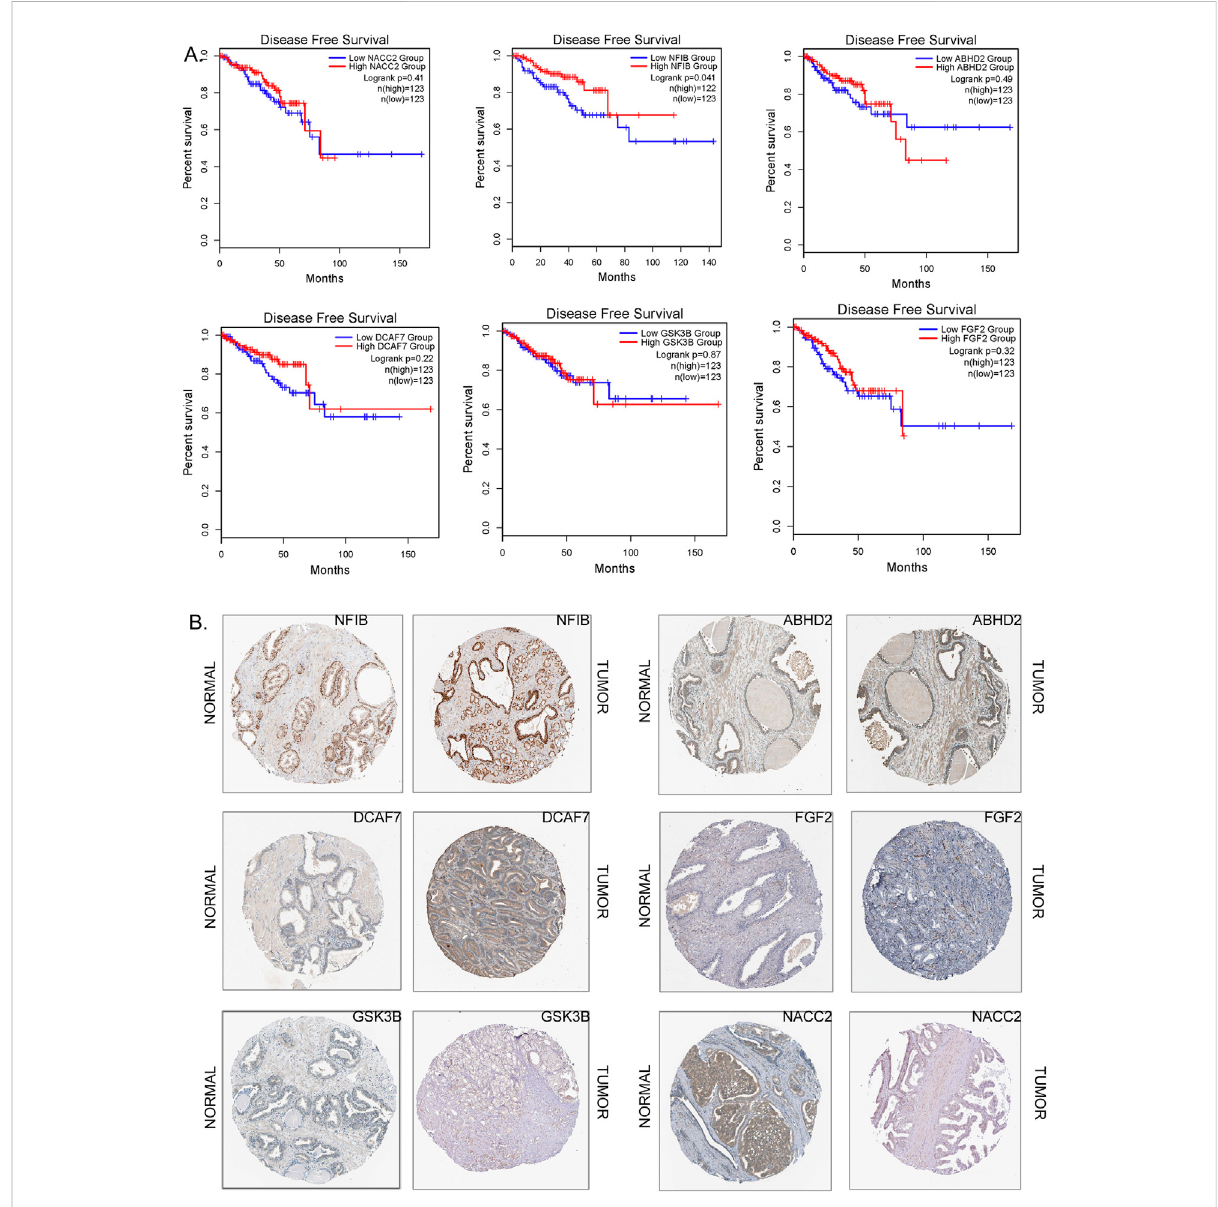
FIGURE 6 (A) TheKaplan-Meiersurvivalcurvesasprognosticvalues(diseasesurvivalindays)ofthehubgenes(NACC2Logrank p =0.41;NFIBLogrank p = 0.041;ABDH2 Logrank p = 0.49; DCAF7 Logrank p = 0.22; GSK3B Logrank p = 0.87; FGF2 Logrank p = 0.32) of prostate cancer. The correlation of survivalstatusofpatientswithdifferentprostatecancersubtypes. (B) Immunohistochemistryofhubgenesinprostatecancersandinnormalprostate tissues (image extracted from